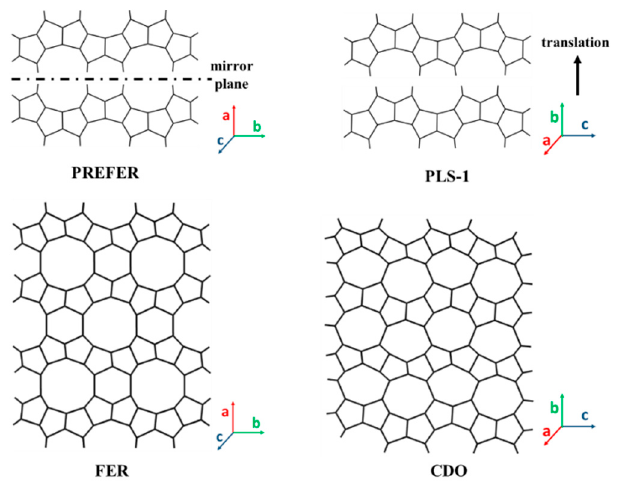
Figure 5. Schematic illustration of structures of 2D layered precursors and the corresponding FER and CDO zeolites.